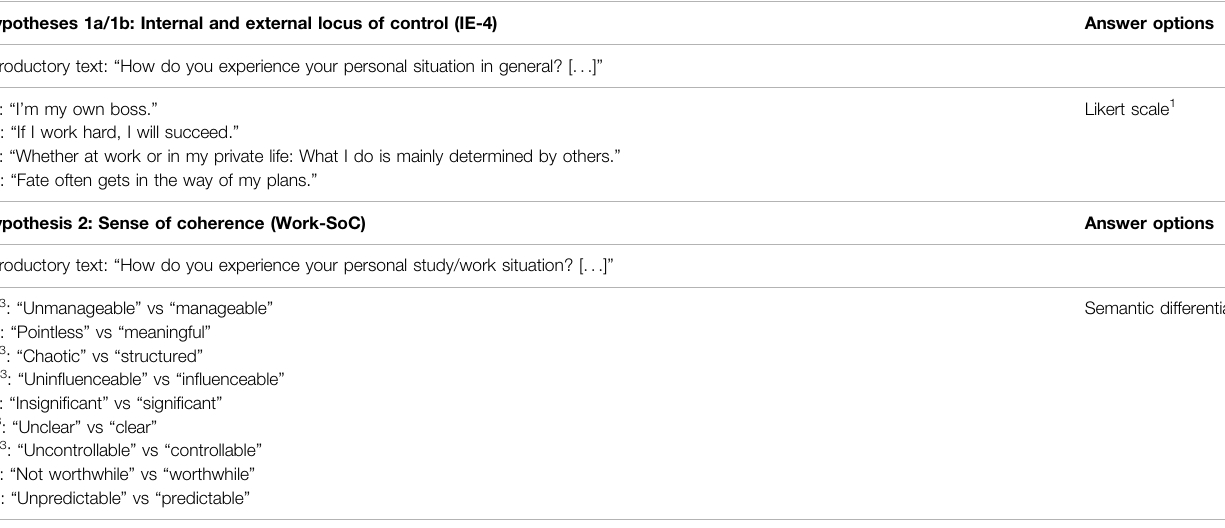
TABLE 1 | Assignment of the translated questionnaire items to the hypotheses (primary endpoints).